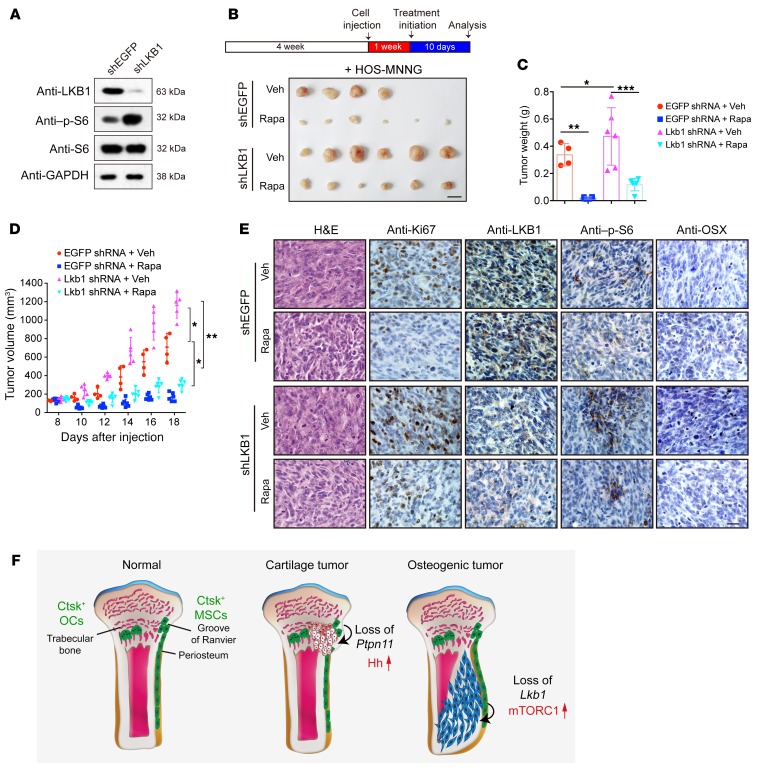
Inhibition of mTORC1 inhibits human osteosarcoma cell growth in nude mice.(A) Western blot result of knockdown efficiency of LKB1 and hyperactivation of mTORC1 pathway in HOS-MNNG cells infected with shLKB1 lentivirus. (B–E) Nude mice were injected with shEGFP and shLKB1 HOS-MNNG cells and treated with 4 mg/kg rapamycin or vehicle control, respectively, daily since tumor establishment for 10 consecutive days. Tumor growth was monitored every 2 days (D), and tumor volume was measured after autopsy (C). Scale bar: 10 mm. Tumors were collected and sectioned for H&E staining. Ki67, LKB1, p-S6, and OSX expression were evaluated via immunohistochemical analysis (E). Scale bars: 20 μm. *P < 0.05. (F) Schematic representation of key findings. Previous findings indicated that Ptpn11 deletion in Ctsk+ cells from the perichondrial groove of Raniver caused cartilage tumors via activating Ihh signaling. Our results suggest that loss of Lkb1 in Ctsk-Cre–expressing mesenchymal progenitor in the periosteum caused osteogenic tumor–like phenotype by increasing mTORC1 activity. Data are represented as mean ± SEM. *P < 0.05; **P < 0.01; ***P < 0.001, 2-way ANOVA.